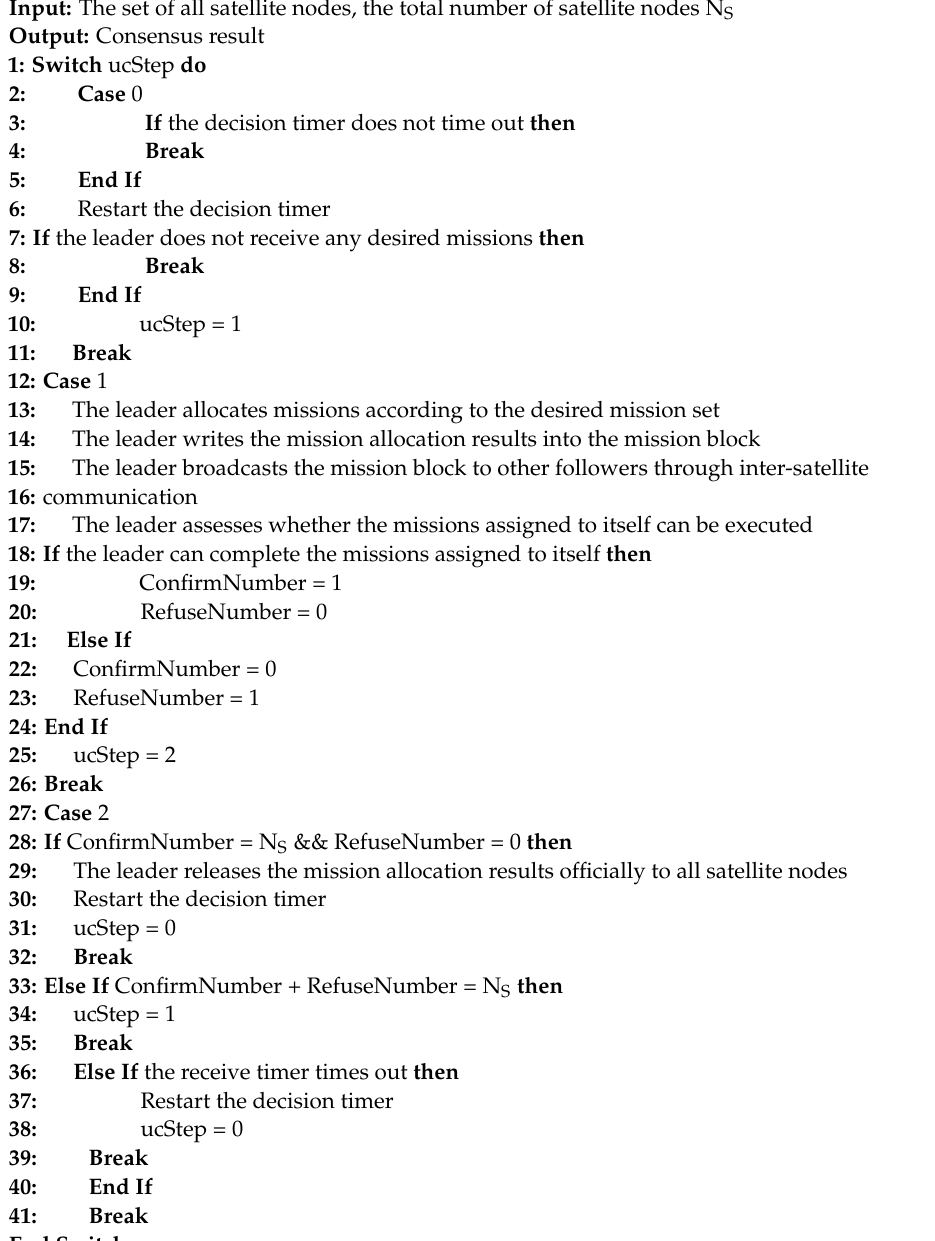
Algorithm 3. The leader decision behavior of the modified RAFT